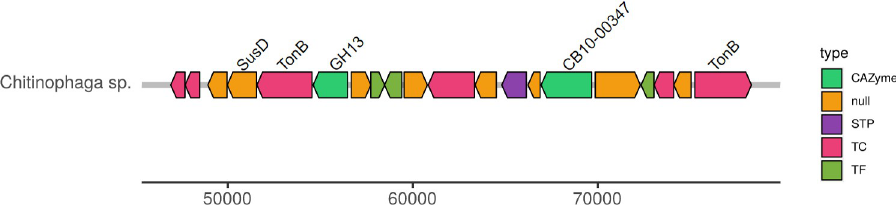
Fig 1. Annotation of genes clustered in “PULs-like” associated with CAZyme GH2 β -mannosidase CB10-00347, obtained from Chitinophaga sp . CB10. The annotation was performed using the CGC-Finder program. The GH2 sequences identified in previous studies (unpublished data) were annotated using the dbcan2 tool [30]. The prediction of putative PUL was proceeded by the CGC-Finder [31]. The CAZyme gene clusters (CGCs) are annotated based